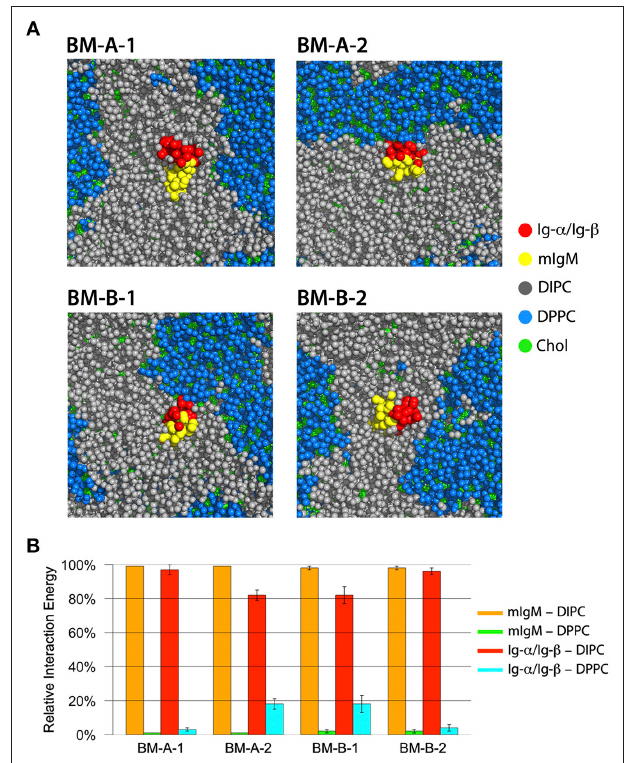
FIGURE 8 | (A) Bottom view of representative structures of BM-A-1, BM-A-2, BM-B-1, and BM-B-2 BCR TMD models inside the DIPC/DPPC/Cholesterol membrane after 2000ns of simulation time. The mIgM dimer is shown in red, the Ig- α /Ig- β in yellow, DIPC in gray, DPPC in blue and cholesterol in green. All molecules are shown in sphere representation. (B) Relative interaction energies between BCR-TMDs and DIPC/DPPC during the last 500ns of simulation time. The error bars indicate standard error obtained from 10 individual